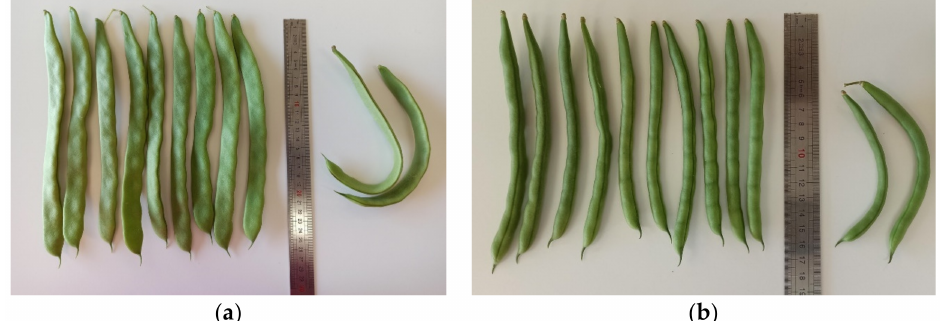
Figure S2. Potential evapotranspiration (ETo) inside the greenhouse along the experiment in 2020 (a) and 2021 (b) seasons. Figure S3. Number of pods on three different sample dates during the 2020 season. Each bar is the average of 4 measurements and vertical lines represent the standard error. Cv ‘Helda’ (Control, brown and RDI, orange) and cv ‘Perfecci ó n Blanca’ (Control, light green and RDI, dark green). No significant differences were found